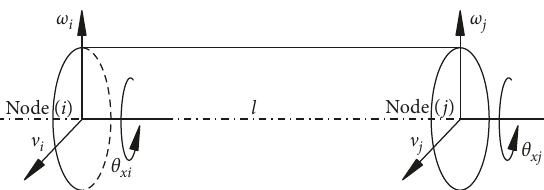
Figure 3: The finite element model of shafting